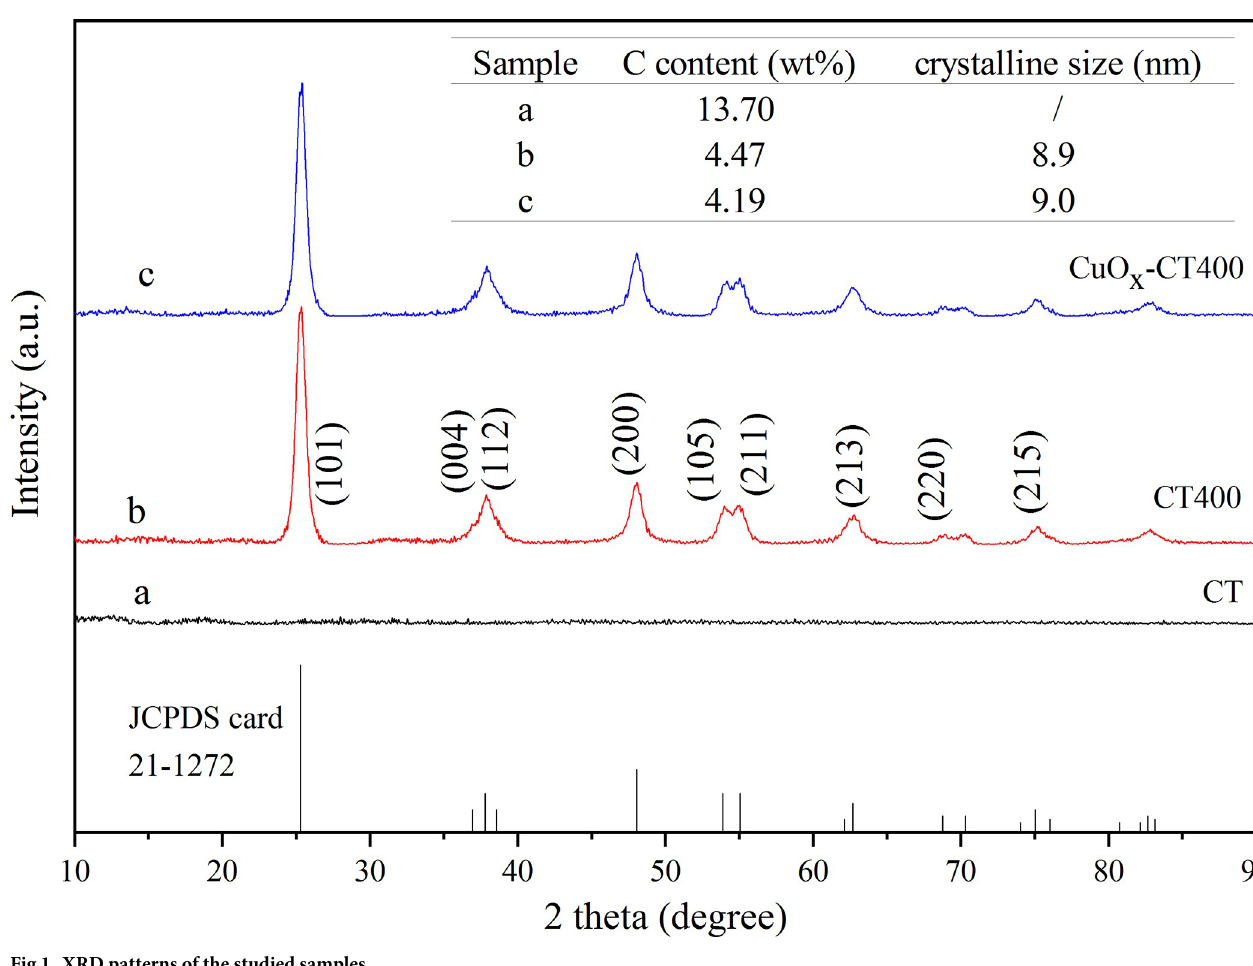
Fig 1. XRD patterns of the studied